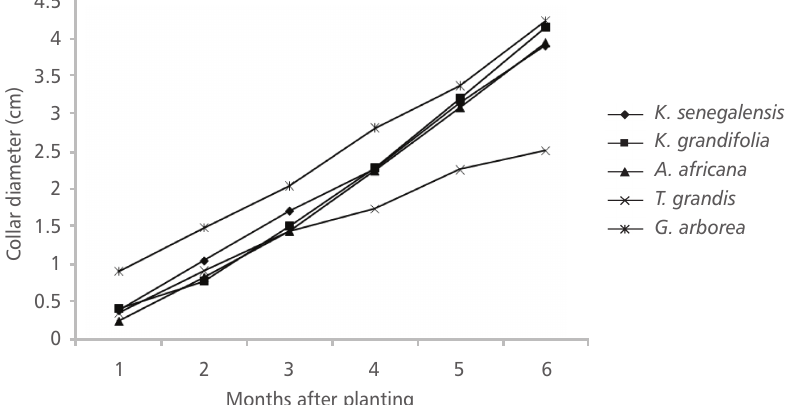
FIGURE 2. Collar diameter growth of the species after six